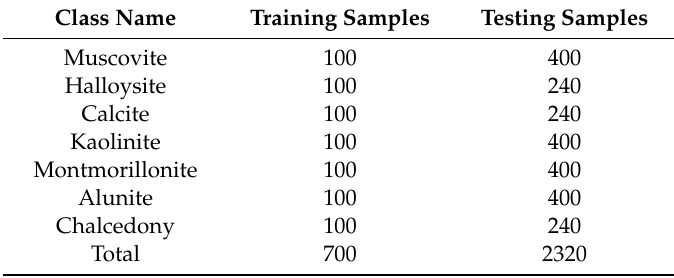
Table 1. Number of training samples and testing samples in the Nevada dataset.